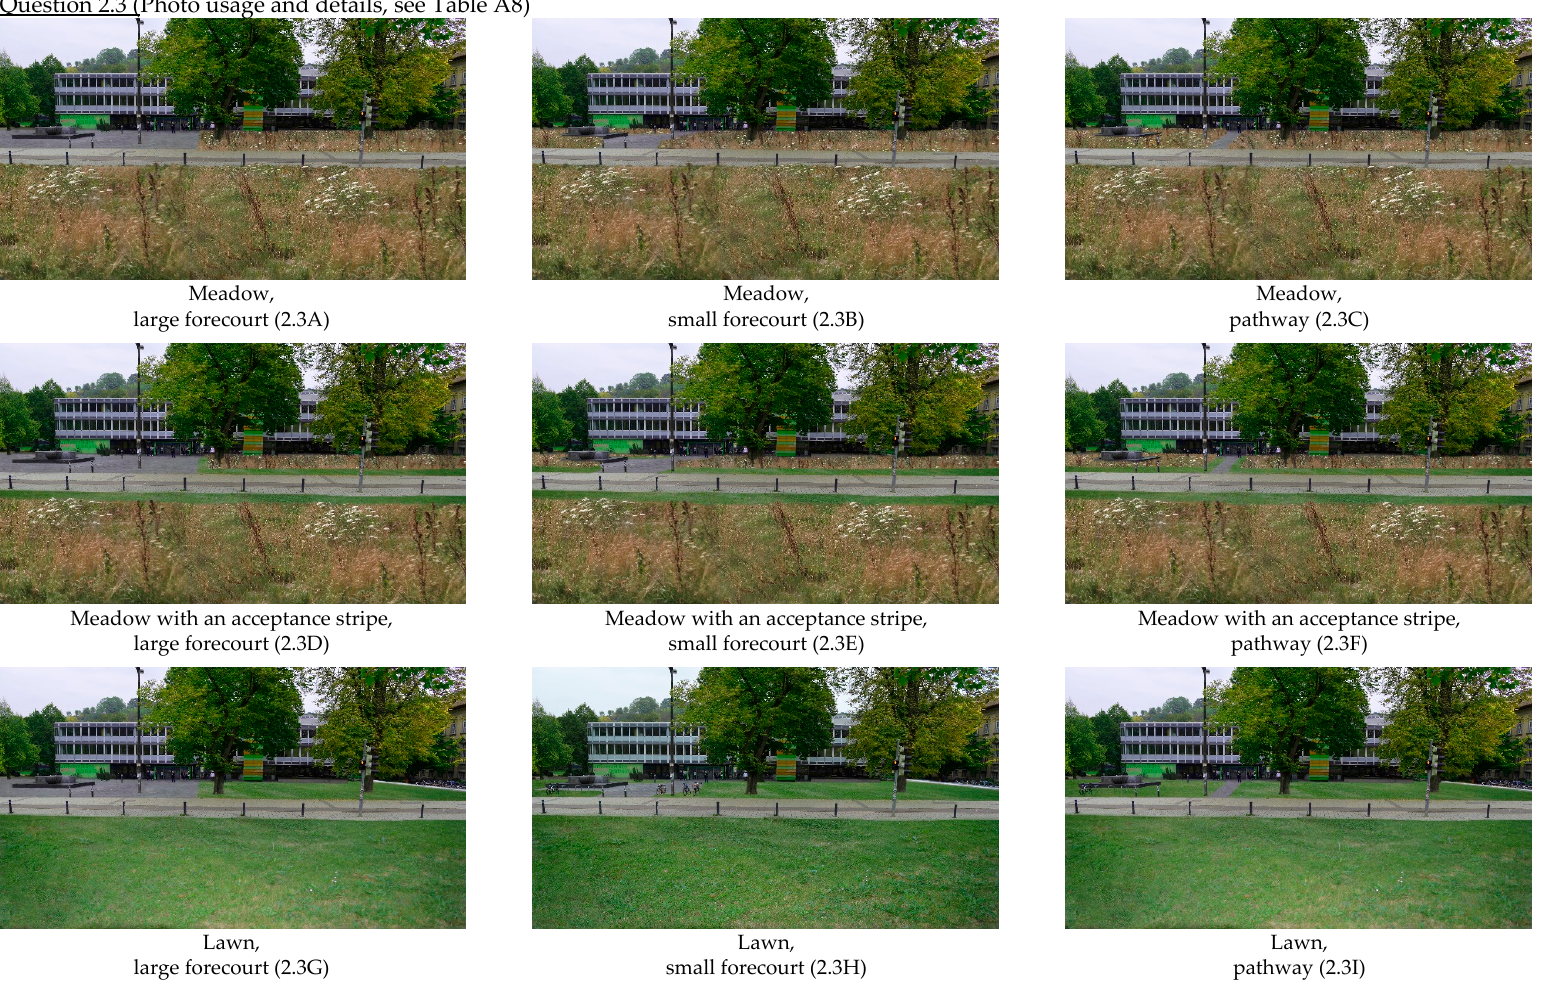
Figure 4. The aim of Question 2.3 was to establish the existence of a preference for a certain type of green space or a preference for the relative area of asphalt in relation to the green area. For further explanations, see text.